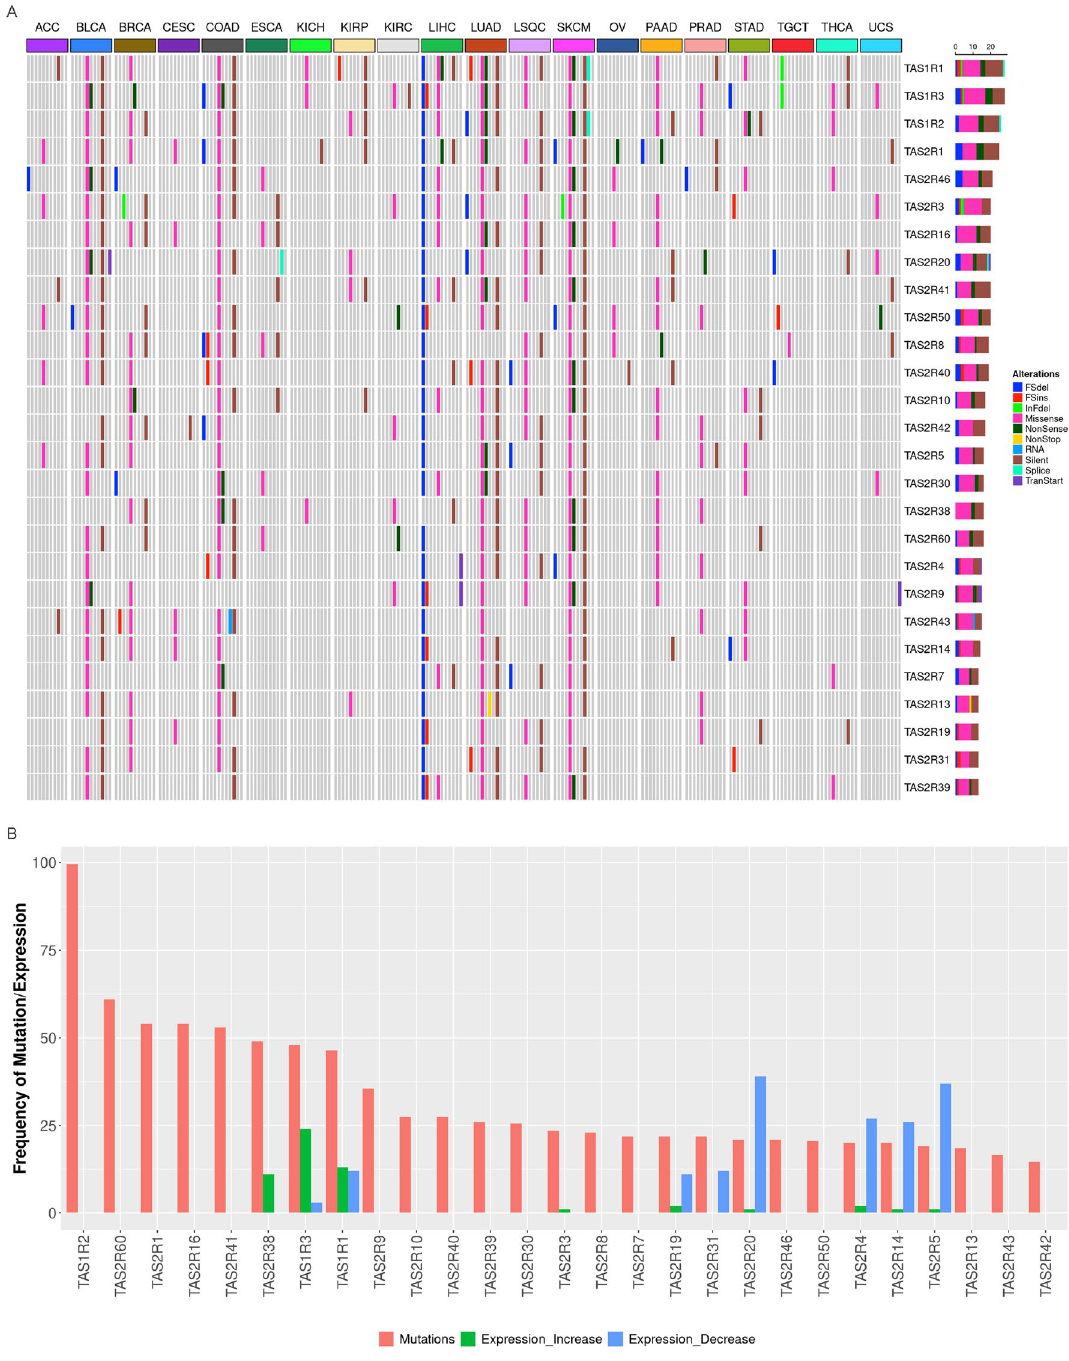
Figure 3. TAS1R and TAS2R mutation types in solid tumors and correlation of gene mutations with expression. ( A ) Mutation landscape showing the different mutation types for TAS1R and TAS2R genes for different TCGA solid tumor types (n = 5103 for 20 tumor types with data available). ( B ) Graph demonstrating the number of tumors with nonsilent taste receptor mutations and the frequency of increased or decreased expression for the same receptor. ACC Adrenocortical Cancer; BLCA bladder cancer; BRCA breast cancer; CESC Cervical Cancer; COAD colon adenocarcinoma; ESCA esophageal cancer; KICH Kidney Chromophobe; KIRC kidney clear cell carcinoma; KIRP kidney papillary cell carcinoma; LIHC liver hepatocellular carcinoma; LSQC lung squamous cell carcinoma; LUAD lung adenocarcinoma; OV ovarian cancer; PAAD pancreatic ductal adenocarcinoma; PRAD prostate adenocarcinoma; SKCM skin cutaneous melanoma; TCGA The Cancer Genome Atlas; TGCT testicular germ cell tumor, THCA thyroid cancer; UCS Uterine